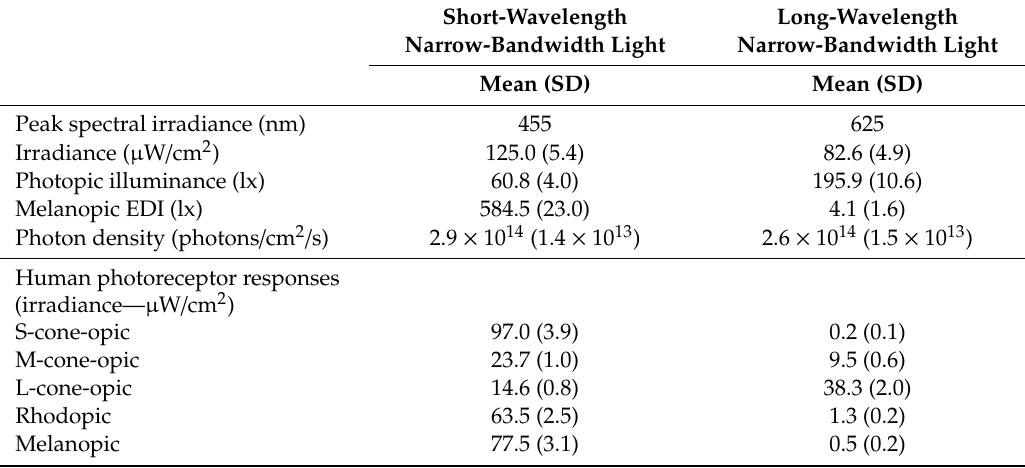
Table 1. Light exposure at eye level (vertical plane) for the two light conditions.